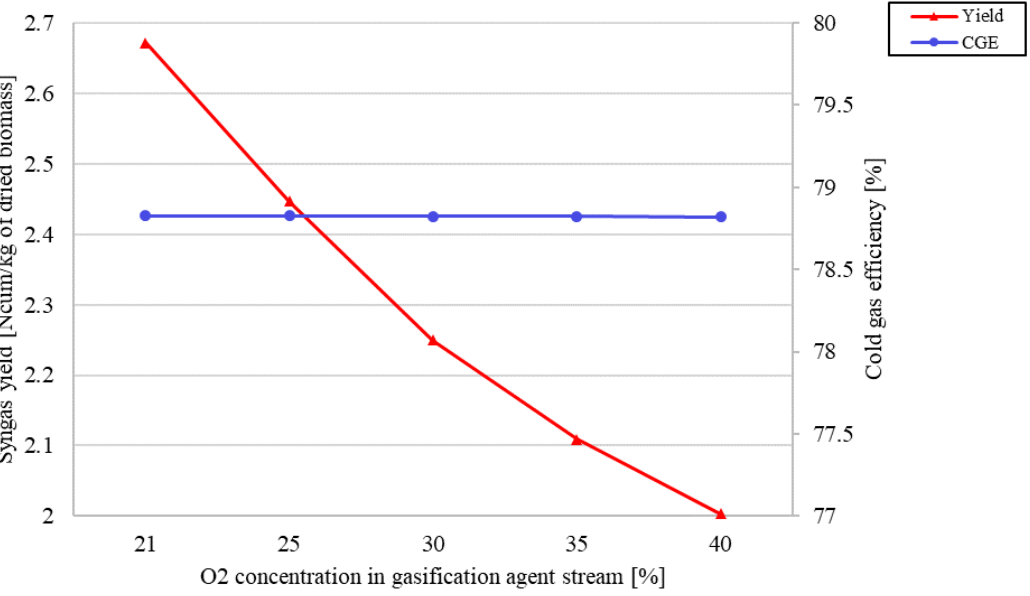
Figure 8. Cold gas efficiency and syngas yield rate as a function of oxygen concentration in the gasification agent.